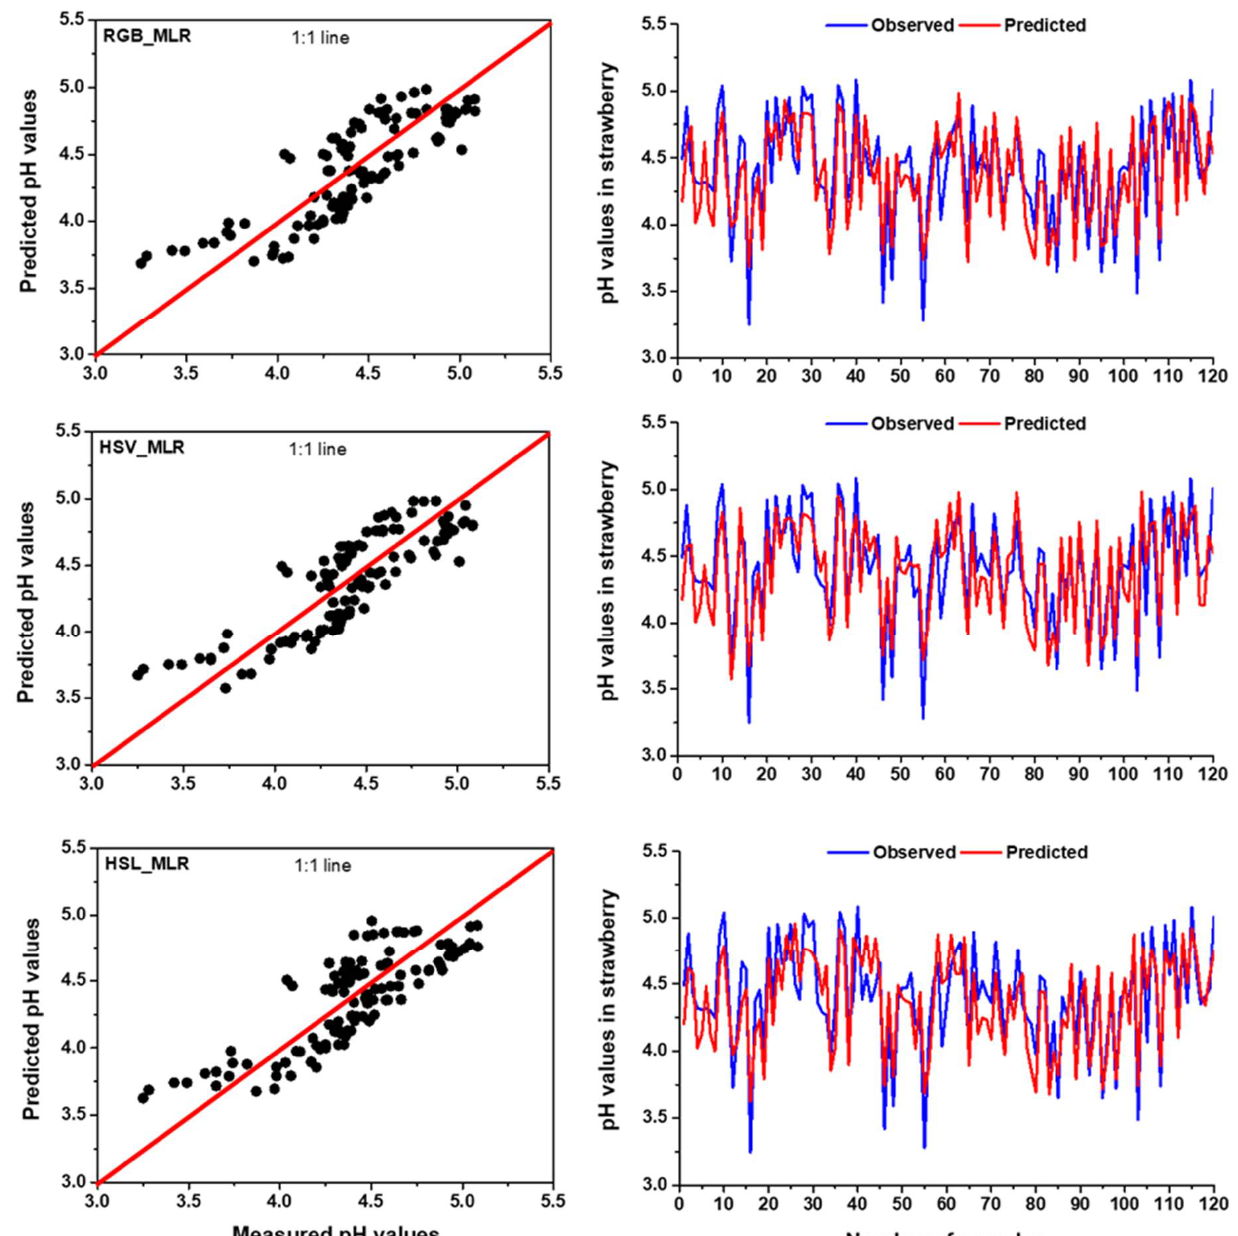
Figure 7. The comparison results between measured and predicted values by MLR model with RGB, HSV and HSL colour spaces for pH prediction in the testing period using time series and scatter plots with 1:1 line. Table 5. Performance metrics (R 2 and RMSE) of the models for predicting TSS of strawberry fruits during the testing and training period. The values in italics indicate the best results in each model among the three colour spaces.